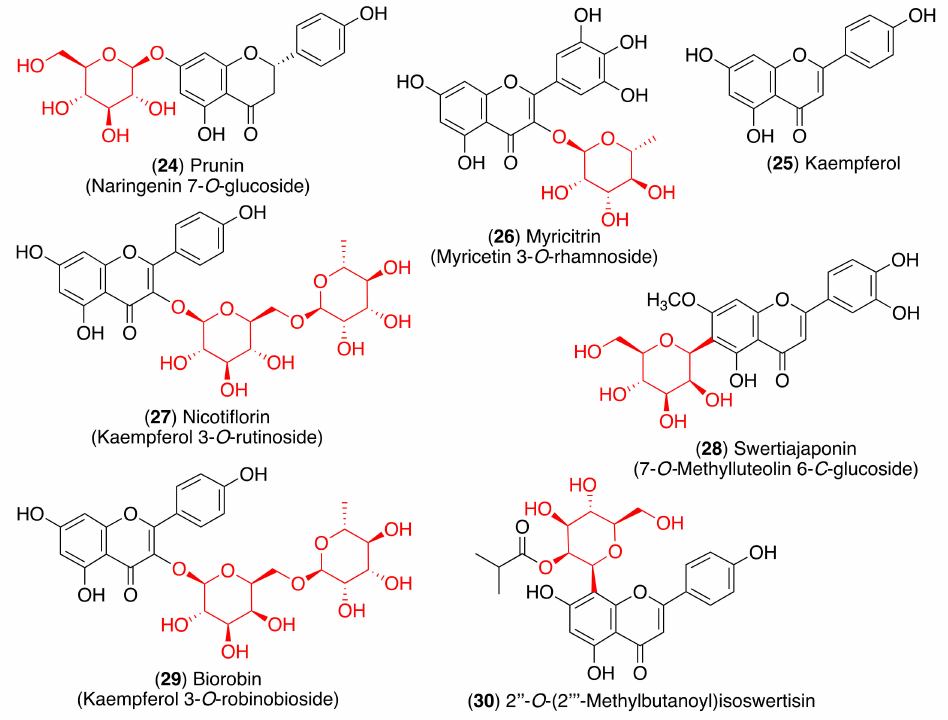
Figure 6. Antiviral glycosyl flavonoids. Table 1. Antiviral activity of glycosyl